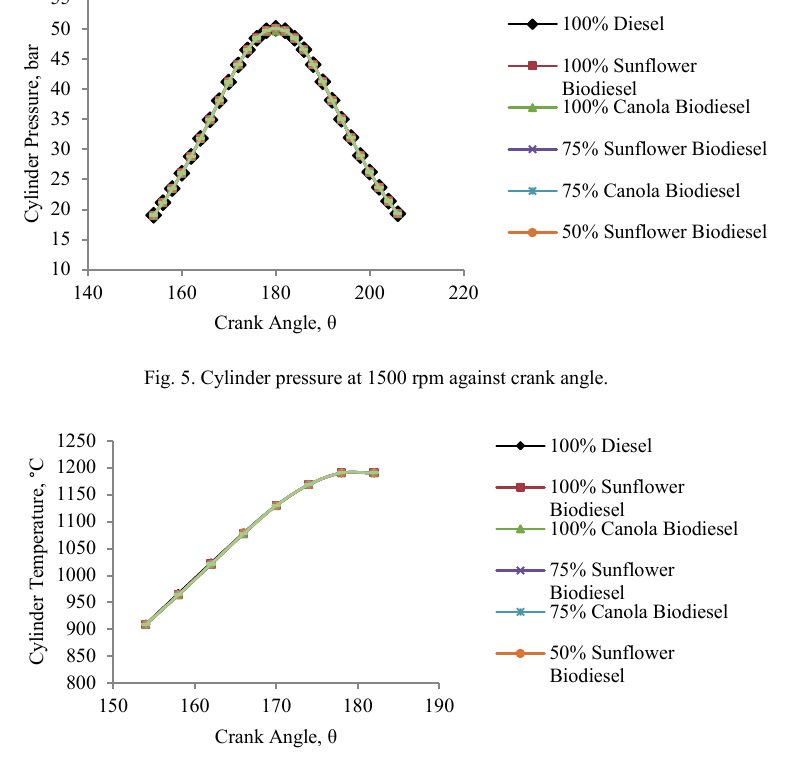
Fig. 6. Cylinder temperature at 1500 rpm against crank